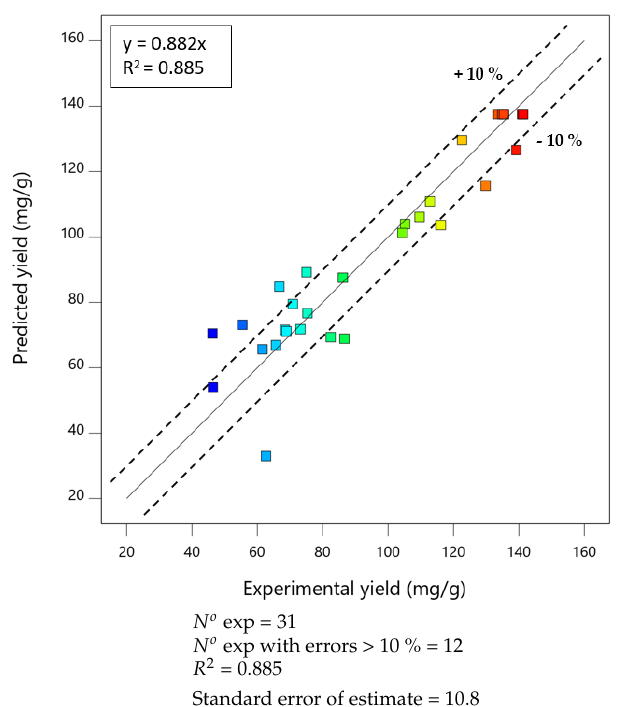
Figure 3. Parity plot for reducing sugars